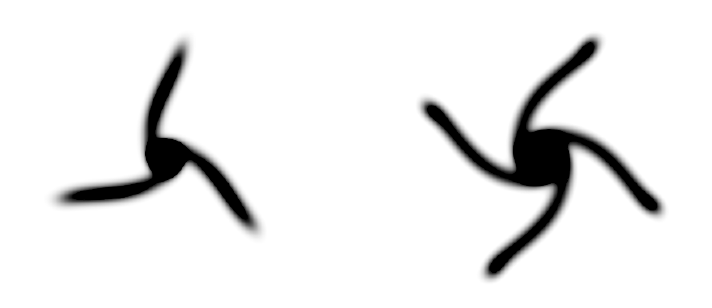
Figure 2 . Late-time horizon shape of unstable ultraspinning Myers-Perry black holes when per- turbed with a tripolar and a quadrupolar mode, and then evolved with the large- D e(cid:11)ective theory. Further evolution of the black hole suggests that the arms pinch, violating CC through ‘death by fragmentation’ [5]. The quadrupolar ‘star’ and its evolution to singular pinches has been recently observed in numerical simulations in D = 6 ; 7 in